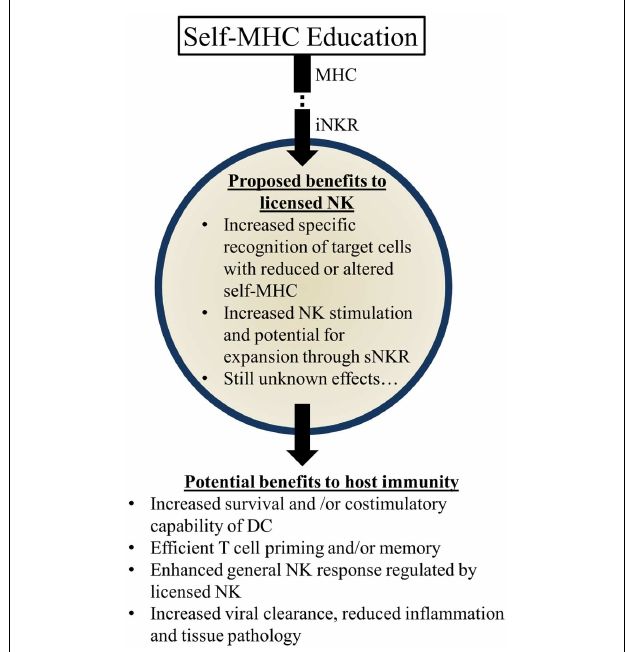
FIGURE 3 | Summary of proposed beneficial effects of licensed-NK cells . NK Licensing potentially impacts the immune response in a variety of ways. Benefits may manifest directly as NK specific recognition or indirectly via effects on their environment and other